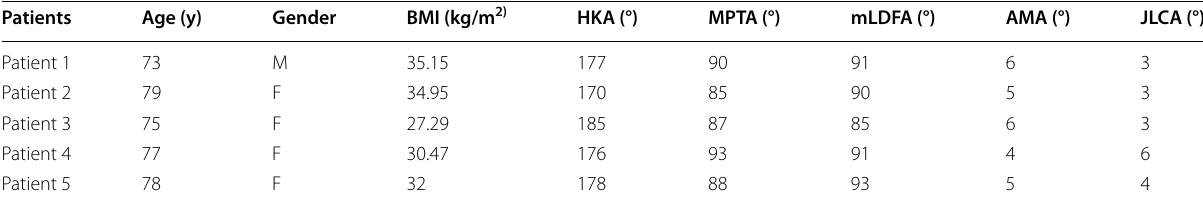
Table 1 Patients